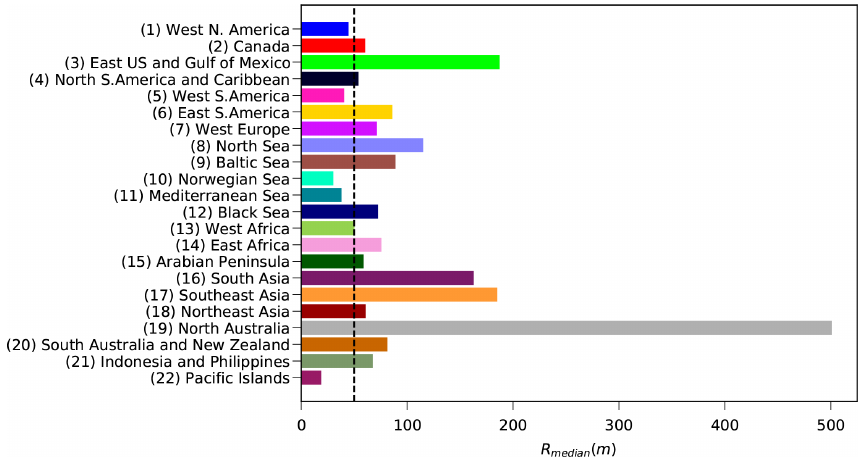
Figure 11. Median coastal recession in meters, calculated per region for the sandy transects assuming 0.5m of SLR across the global coastline. The vertical dashed line indicates the recession of 50m, which would be the result if a 1 / 100 nearshore slope was